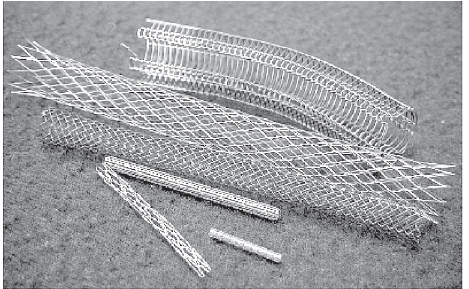
Figure 7. Shape memory self-ex- panding stents. Taken from Ref. 28